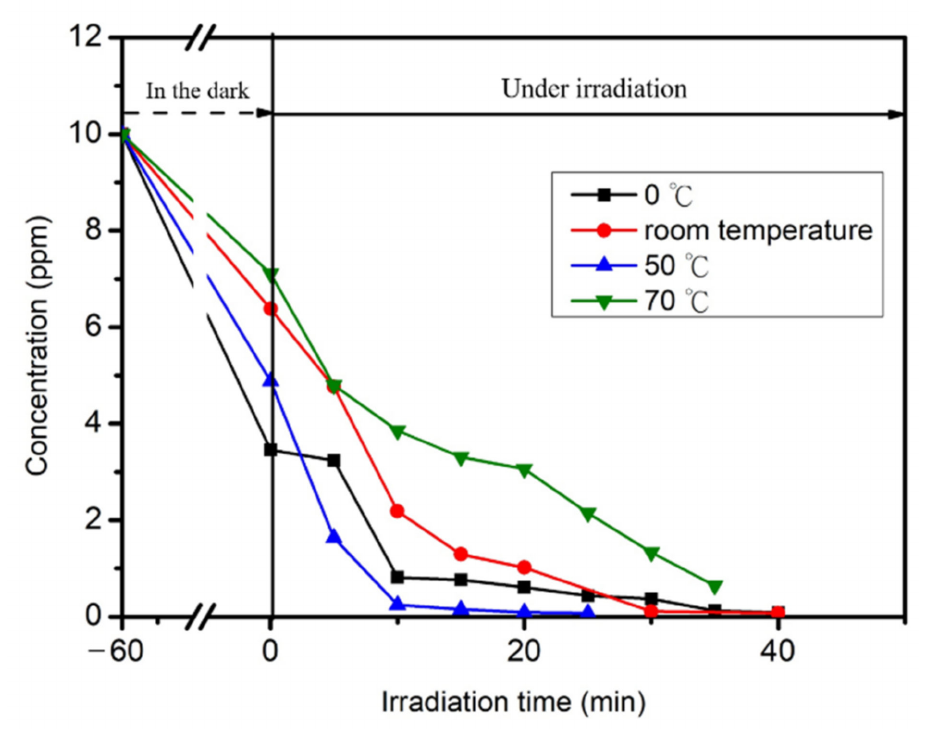
Figure 8. The change of the concentration of methylene blue on Pd/TiO 2 with time at different reaction temperatures.